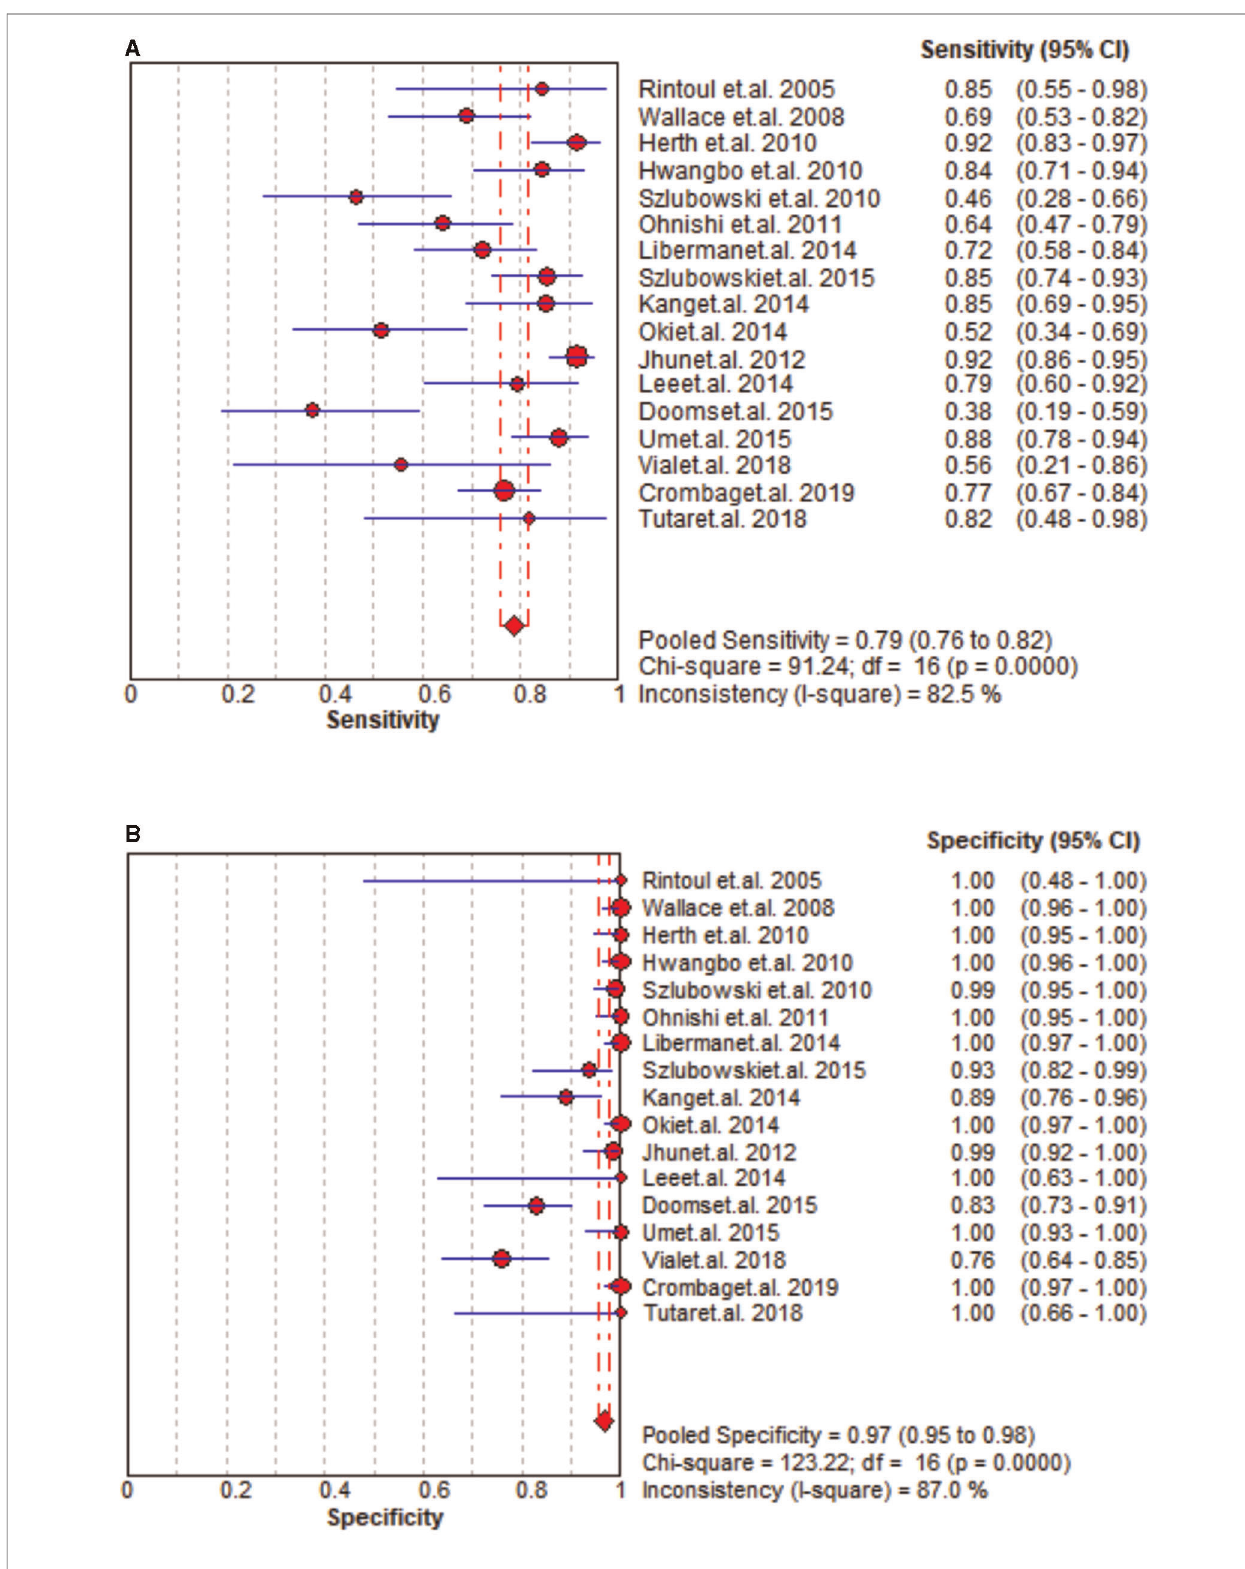
FIGURE 2 | Summary of pooled sensitivity and speci fi city of